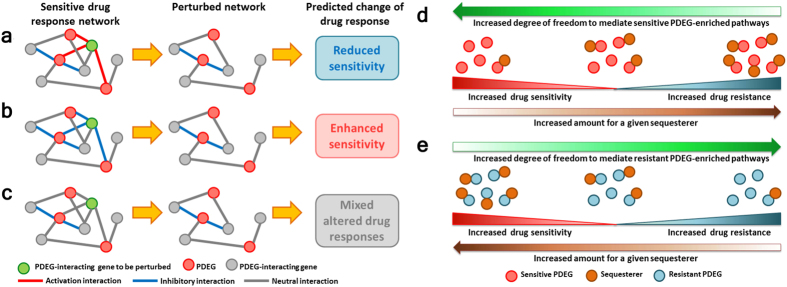
Plausible molecular mechanisms that regulate directionality of drug response when a PDEG-interacting gene is perturbed.(a) Reduced sensitivity to drug is predicted if the expression of a PDEG-interacting gene that exhibits positive (activation) interactions (indicated by red lines) to multiple PDEGs is suppressed. (b) Enhanced sensitivity to drug is predicted if the expression of a PDEG-interacting gene that exhibits negative (inhibitory) interactions (indicated by blue lines) to multiple PDEGs is suppressed. (c) Mixed altered drug responses (enhanced or reduced drug sensitivity or non-response) is predicted if the expression of a PDEG-interacting gene that exhibits neutral interactions to multiple PDEGs is suppressed. (d) Effects of a single PDEG-interacting gene from sensitive response network in modulating drug sensitivity. Increased levels of a PDEG-interacting gene sequester its interacting PDEGs and restrict them from interacting with other PDEGs or PDEG-interacting genes, thereby promoting drug resistance. However, decreasing the level of the PDEG-interacting gene frees its interacting PDEGs to interact with other PDEGs or PDEG-interacting genes and gives rise to enhanced drug sensitivity. (e) Effects of a single PDEG-interacting gene from resistant response network in modulating drug sensitivity. Increased levels of a PDEG-interacting gene sequester its interacting PDEGs and restrict them from interacting with other PDEGs or PDEG-interacting genes, thereby promoting drug sensitivity. However, decreasing the level of the PDEG-interacting gene frees its interacting PDEGs to interact with other PDEGs or PDEG-interacting genes and gives rise to enhanced drug resistance.